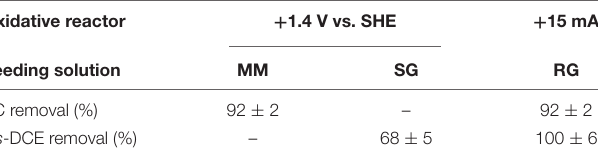
TABLE 5 | Oxidative reactor performances with the three feeding solutions: Mineral Medium (MM), Synthetic groundwater (SG), and Real Groundwater (RG). Oxidative reactor + 1.4 V vs. SHE + 15 mA Feeding solution MM SG